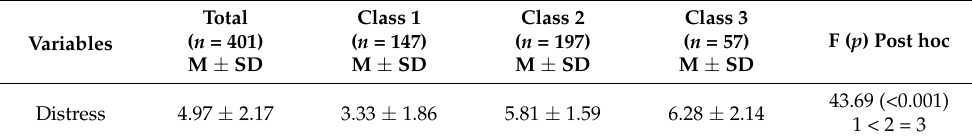
Table 4. Comparison of distress between the three classes ( N = 401).